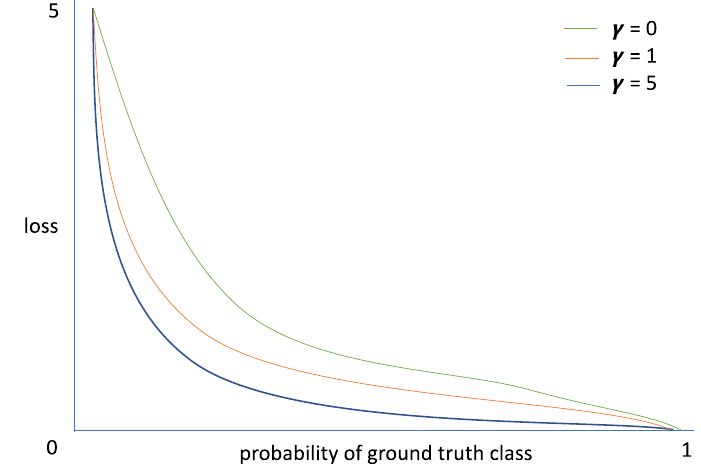
Figure 13. Focal loss Reprinted with permission from Ref. [36]. 2017, Lin, T.-Y.